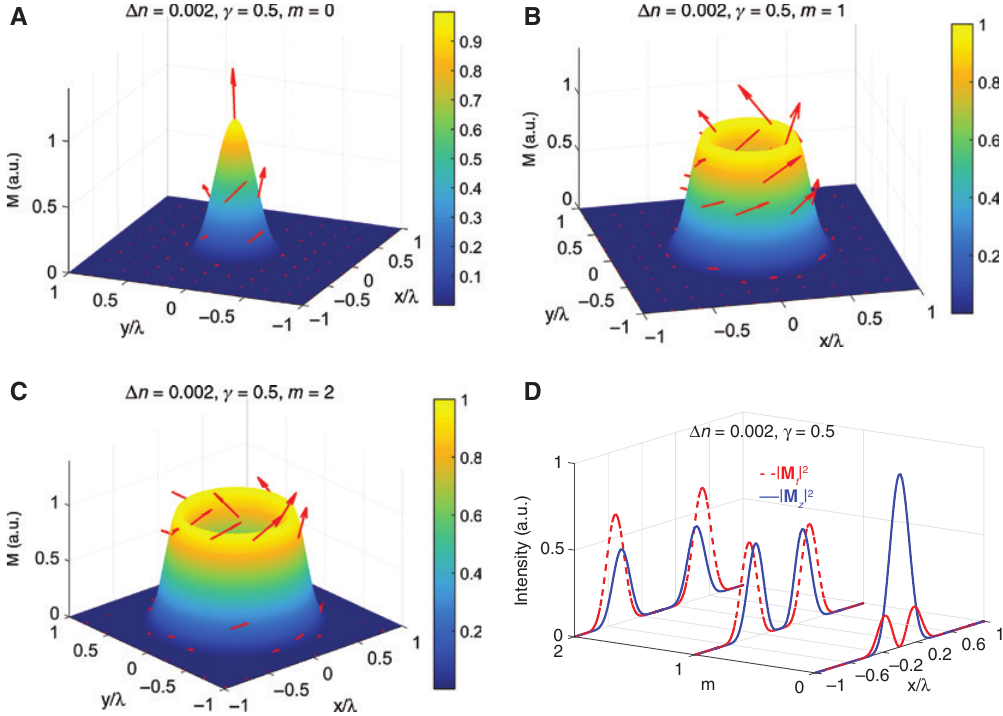
Figure 2: Magnetization pattern influenced by topological charge. (Color online) Topological charge effect on the optically induced magnetization in a medium of Δ n = 0.002 and γ = 0.5 with topological charge of (A) m = 0, (B) m = 1, and (C) m = 2. The orientation of the magnetization is indicated by arrows. (D) Cross-section of the transverse and longitudinal components for the cases of m = 0, m = 1, and m =